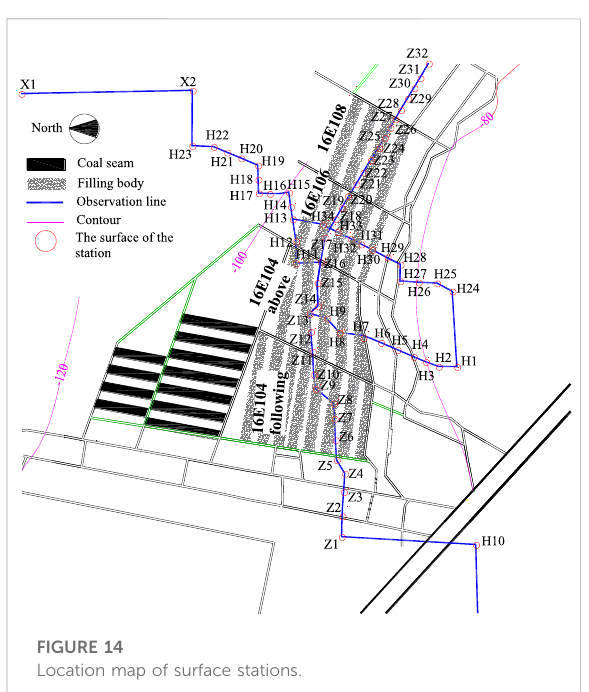
FIGURE 14 Location map of surface